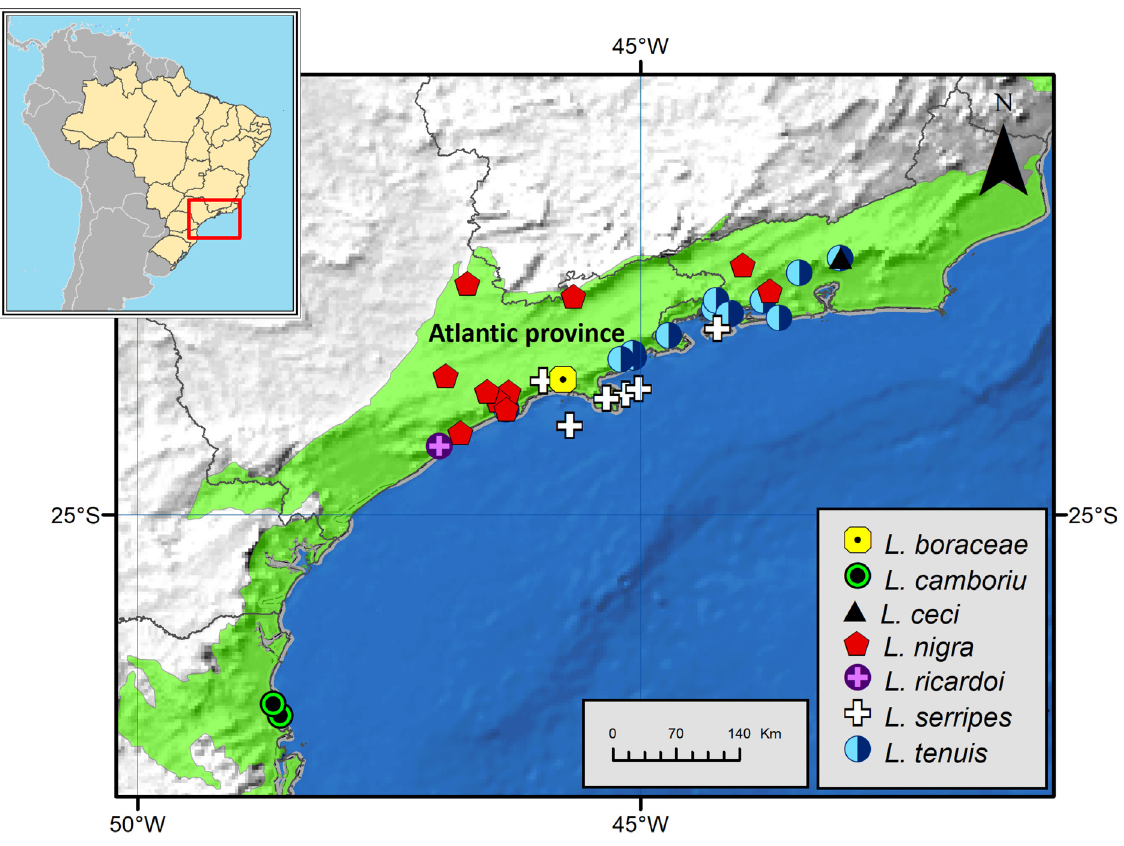
Fig. 5. Southeasten and Southern regions of Brazil, showing the distribution of the Lacronia spp. The area shaded in green represents the Atlantic province, as proposed by Morrone et al.